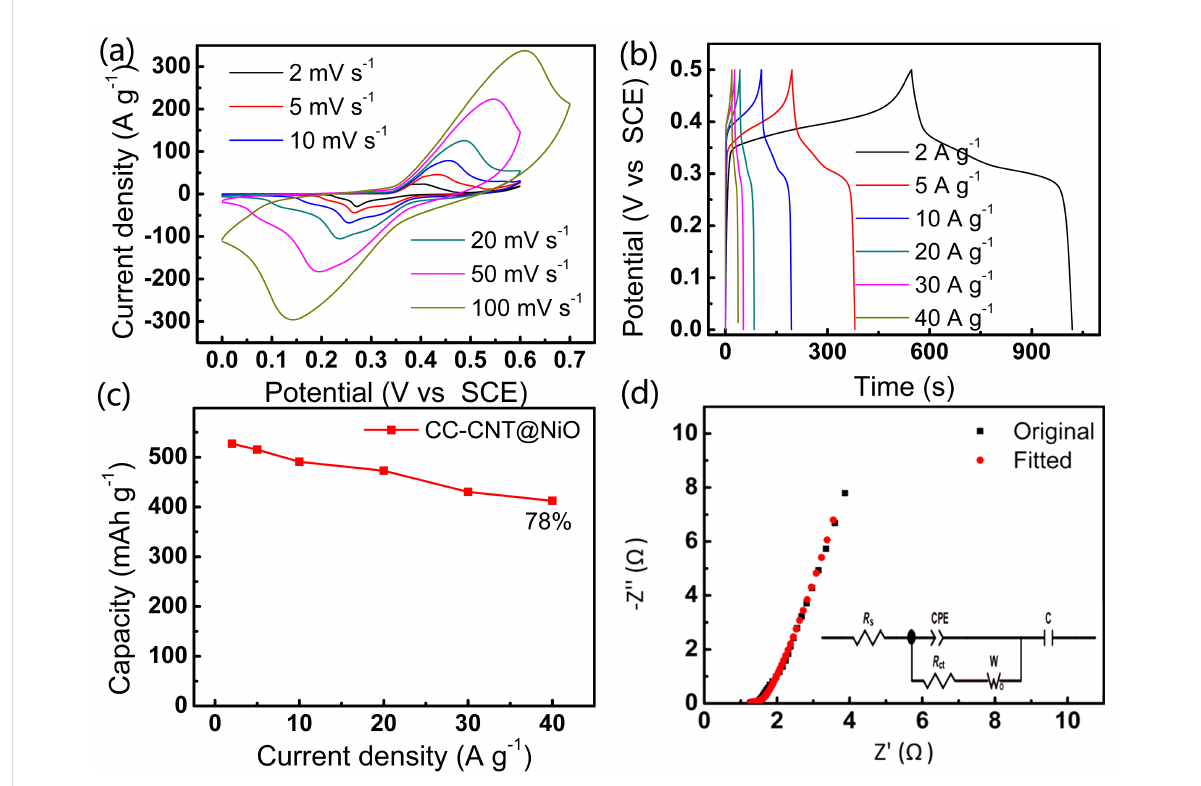
Figure 7: Electrochemical performance of the CC-CNT@NiO electrode: (a) CV curves; (b) GCD curves; (c) capacity versus current density; (d) EIS curve.